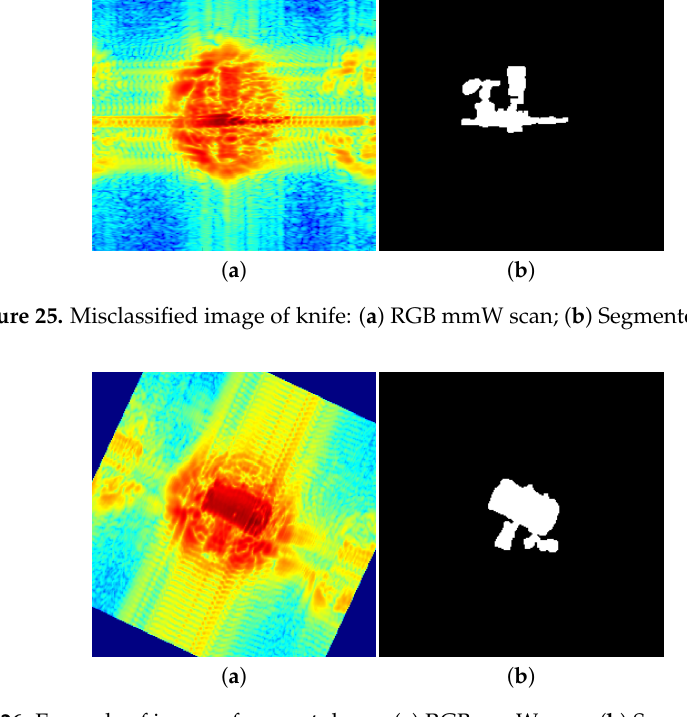
Figure 26. Example of image of a smartphone: ( a ) RGB mmW scan; ( b ) Segmented